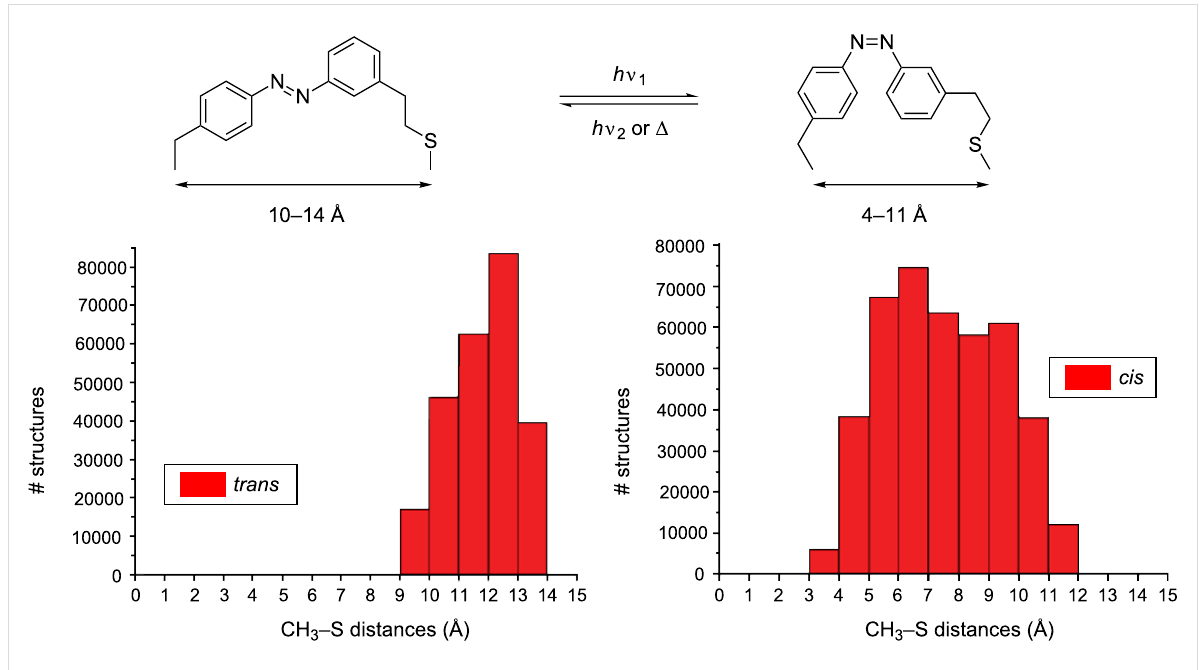
Figure 1: Histogram showing the distribution of end-to-end distances of the trans and the cis form between the C atom of the methyl group and cysteine S of the built-in photocontrollable bridge.